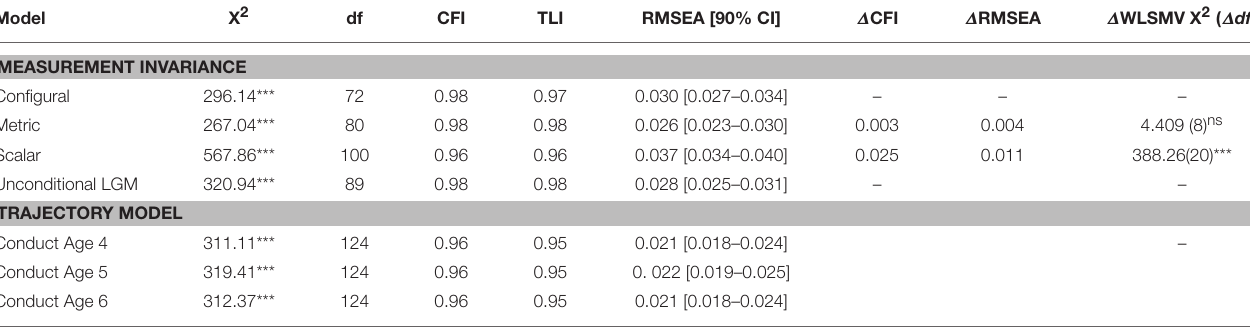
TABLE 3 | Fit indices for measurement invariance, unconditional latent growth model (LGM), and trajectory model.